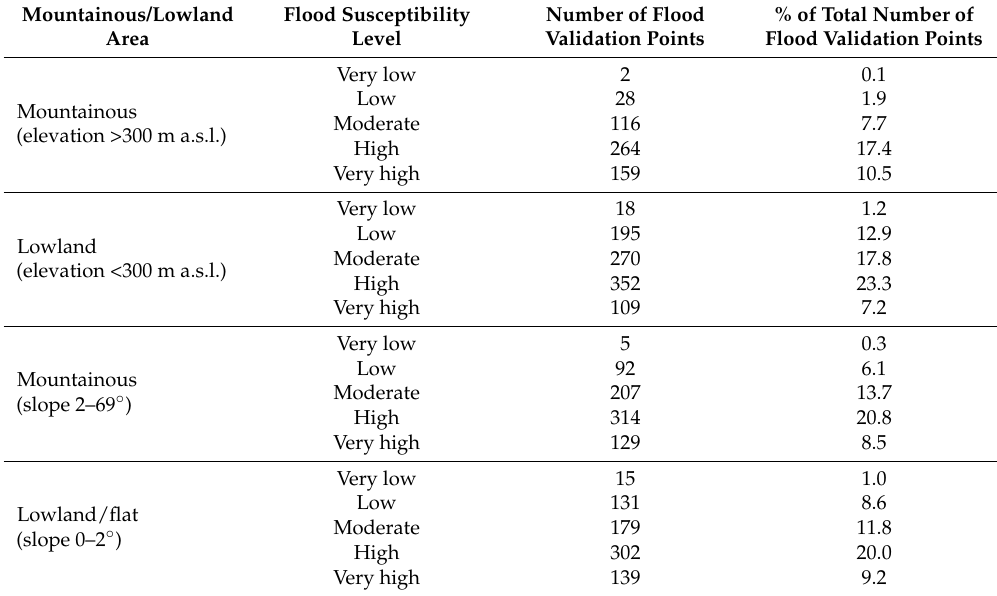
Table 7. Flood validation points and their share in mountainous/lowland (flat) areas. Mountainous/Lowland Flood Susceptibility Number of Flood Area Level Validation Points Mountainous (elevation >300 m